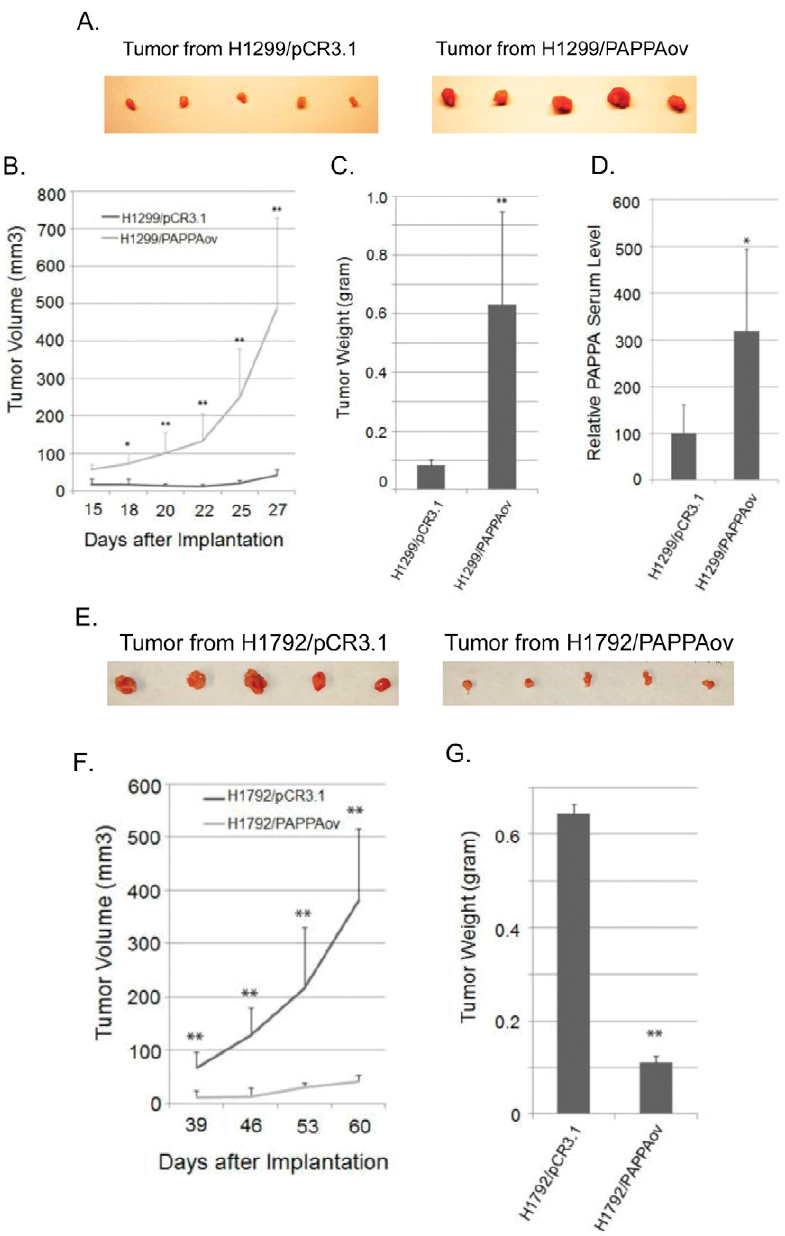
Figure 5. Effect of PAPPA expression on xenograft tumor growth. (A) Image of tumor size from H1299 cells at the time of dissection. (B) Growth curve of xenograft tumor. H1299/pCR3.1 and H1299/PAPPAov cells were injected subcutaneously into 4 weeks old NOD/SCID females. (C) Wet tumor weight at the time of dissection. (D) PAPPA serum level of tumor bearing mice determined by ELISA at the end of experiments. (E) Image of tumor size from H1792 cells at the time of dissection. (F) Growth curve of xenograft tumor. H1792/pCR3.1 and H1792/PAPPAov cells were injected subcutaneously into 4 weeks old nu/nu athymic mice. (G) Wet tumor weight at the time of dissection. Tumor sizes were measured and calculated as described in the Materials and Methods. Results were expressed as mean tumor volume (mm 3 ) 6 SD (n=5). *: p , 0.05; **: p , 0.01 (student t test).